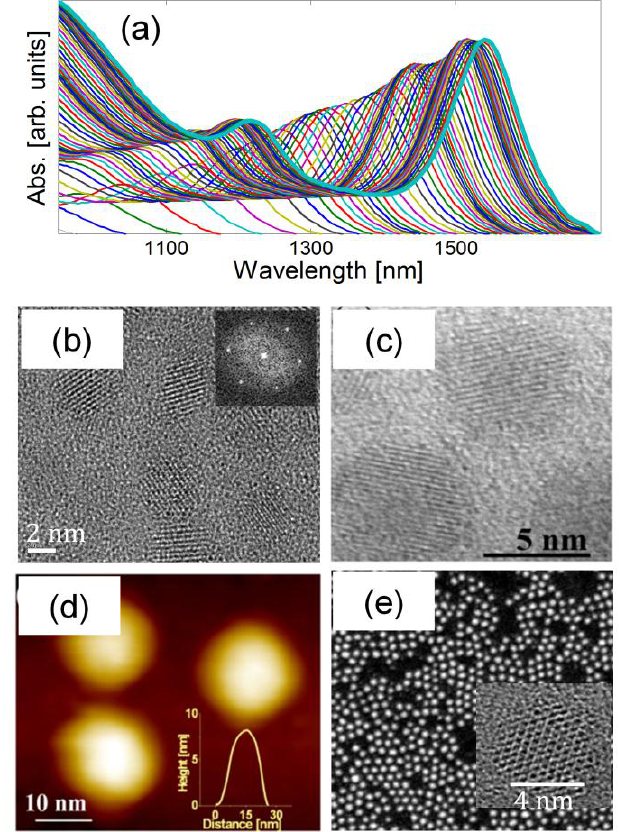
Figure 10. ( a ) Representative absorption spectra of PbSe QDs monitored in situ during their synthesis and recorded with a time interval of 10 s; ( b ) HRTEM image of PbSe/PbS QDs; R s /R c = 2.1/1.5 nm. Inset: FFT pattern of the same QDs; ( c ) HRTEM image of PbSe/PbS QDs; R s /R c = 3.0/1.5 nm; ( d ) STM image of PbSe/PbS QDs; R s /R c = 4.0/1.5 nm. Inset: Height profile of a single QD; ( e ) STEM image of PbSe/PbSe x S 1– x core/alloyed-shell QDs; R s /R c = 2.5/1.5 nm. Inset: HRTEM image of a single